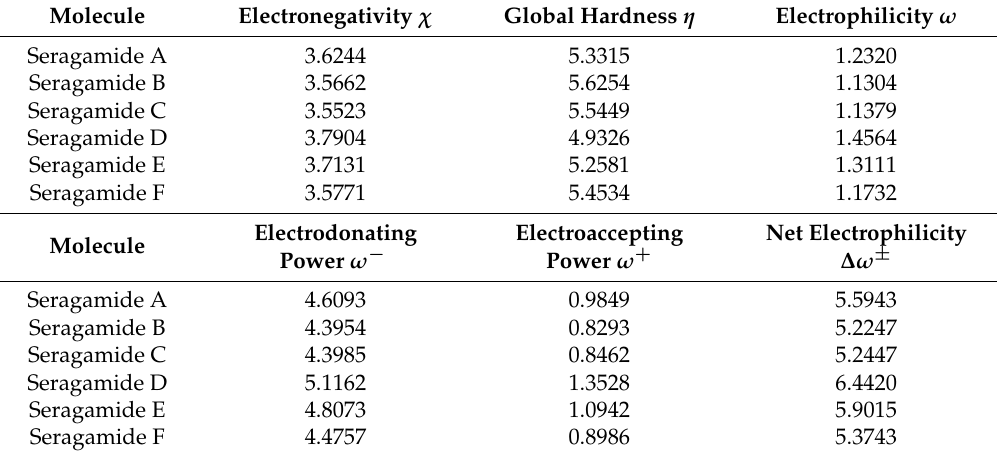
Table 2. Global reactivity descriptors of Seragamides A–F calculated with the MN12SX/Def2TZVP/ H 2 O model